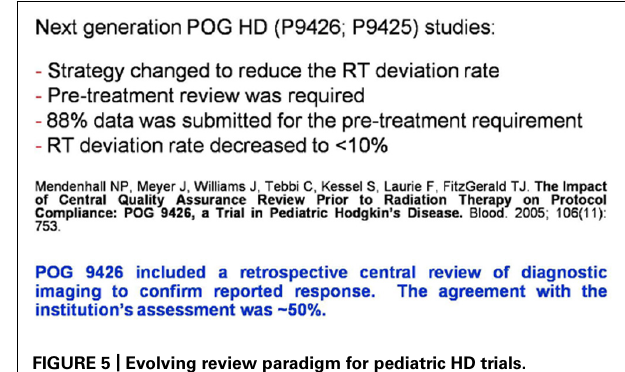
FIGURE 5 | Evolving review paradigm for pediatric HD